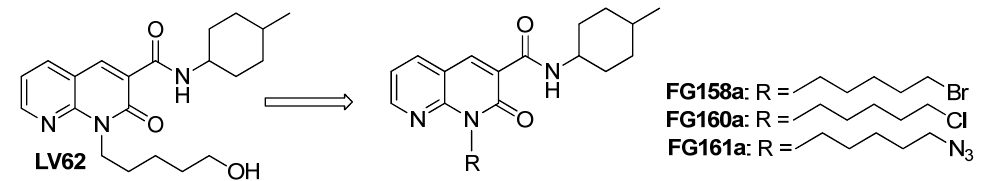
Figure 2. Design of the novel 1,8-naphthyridin-2(1 H )-one-3-carboxamide